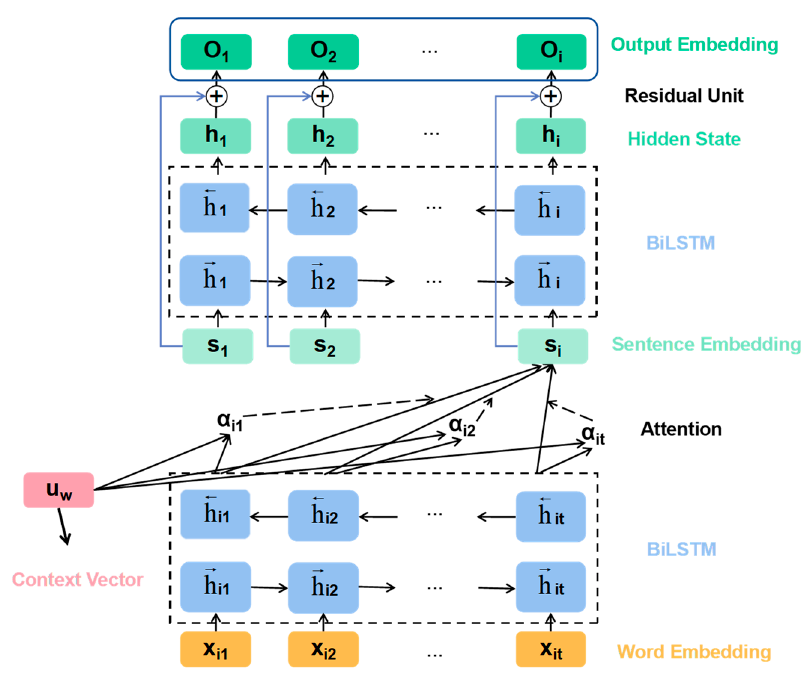
Figure 4. Residual two-layer BiLSTM structure with attention.